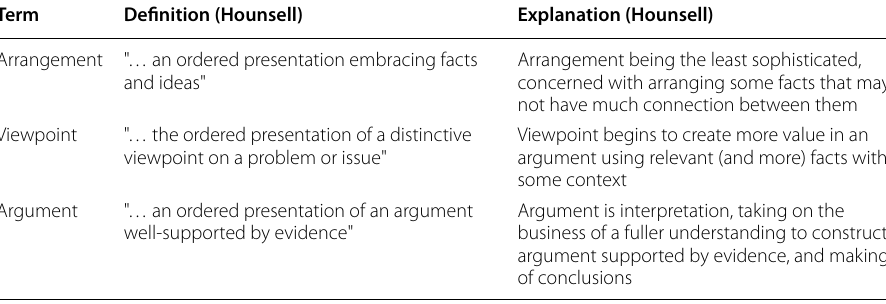
Table 4 Arrangement, viewpoint, argument, from Hounsell (2005, pp. 111, 113)